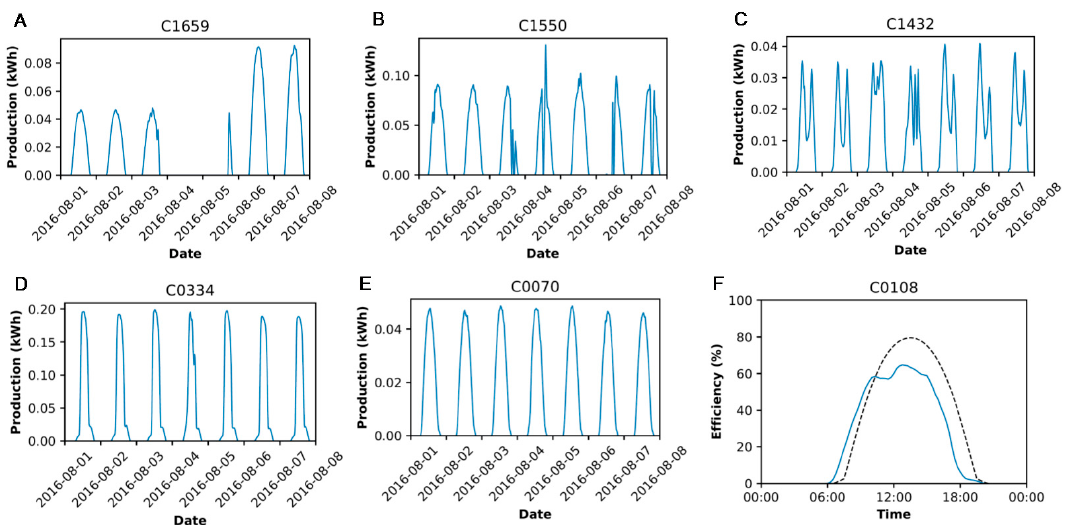
Figure 5. Examples of photovoltaic (PV) systems detected with production anomalies under favourable weather conditions. ( A ) PV system with sustained daytime zero-production; ( B ) PV system with brief daytime zero-production; ( C ) PV system with daytime shading; ( D ) PV system with sunrise and sunset shading; ( E ) PV system with low maximum production; and ( F ) PV system with suboptimal orientation.